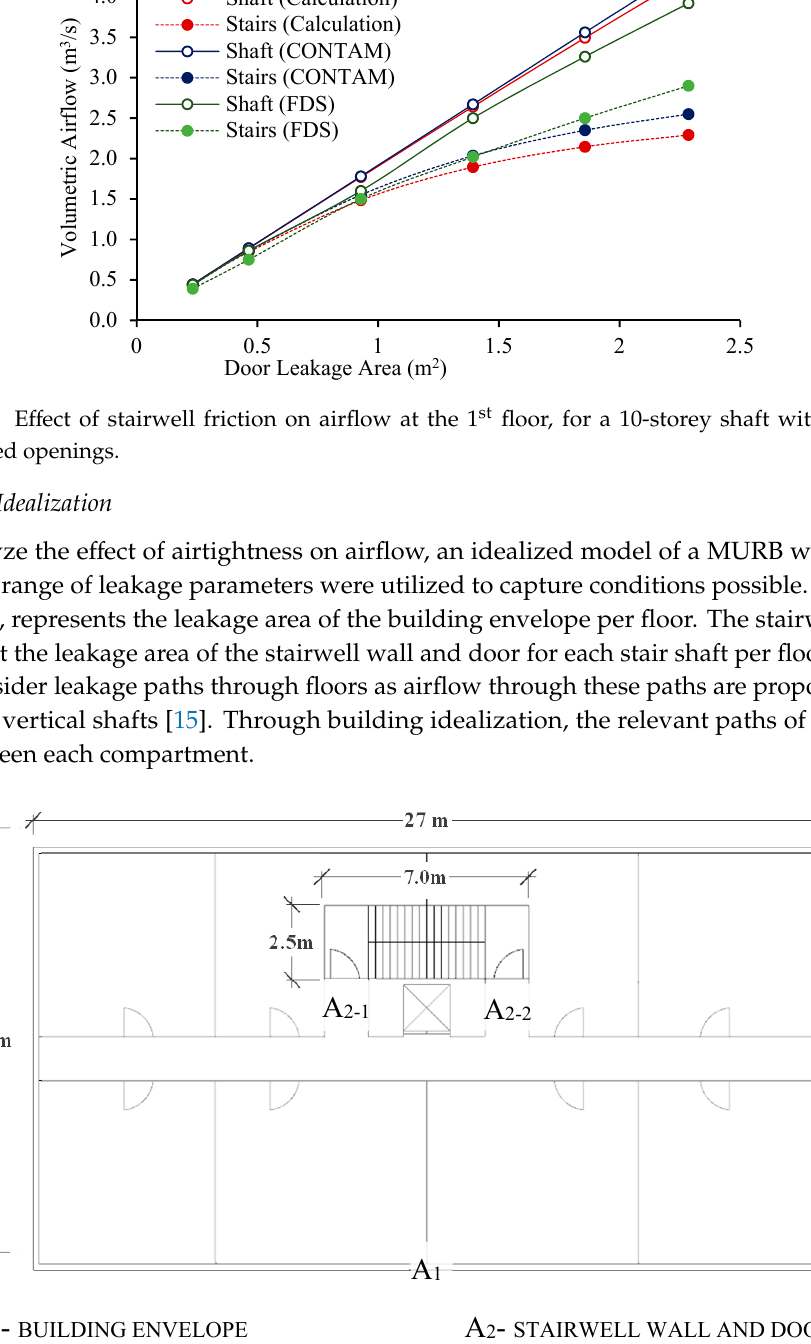
Table 3. Idealized building component parameters.